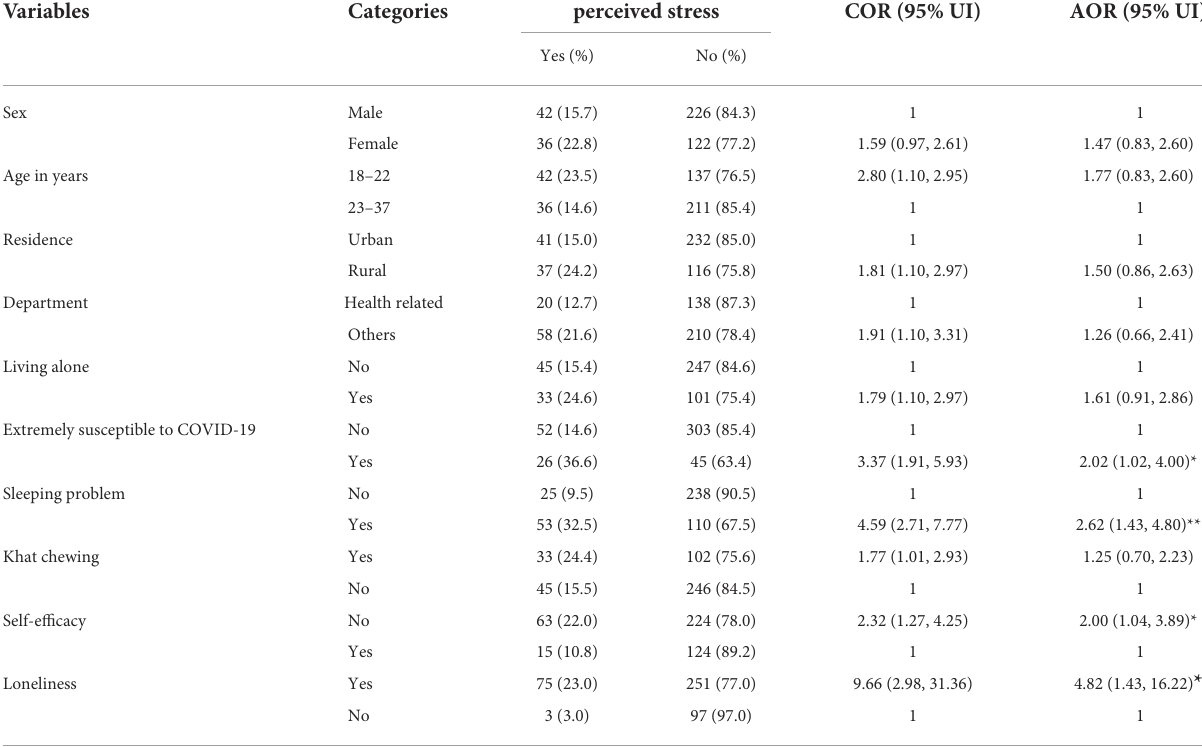
TABLE 3 Associated factors of perceived stress, among university students in Ethiopia, 2021 ( n =